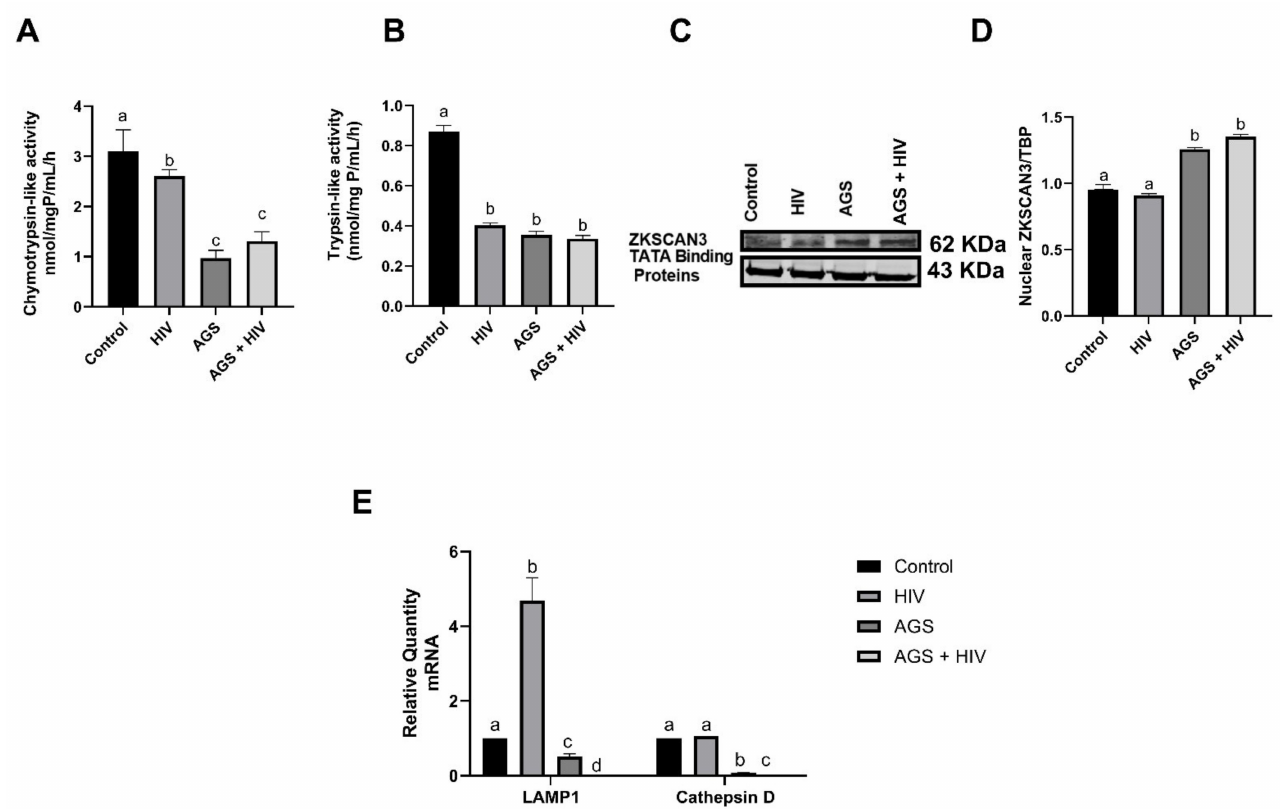
Figure 6. AGS and HIV enhance ZKSCAN3 but suppress TFEB target genes. ( A , B ) Cht-L, and T-L proteasome peptidase activities were detected in cell lysates by in vitro assay using fluorimetric substrates ( C ) Immunoblot analysis of ZKSCAN3 protein expression in RLW nuclear fraction. Equal (20 µ g) amounts of protein were loaded in each lane. β -actin was used as an internal control. ( D ) Quantification of immunoreactive bands of ZKSCAN3 from 3 independent experiments. ( E ) LAMP1 and cathepsin D mRNA expression detected by RT-PCR analysis. GAPDH mRNA was used as an internal control. Data are from 3 independent experiments, presented as the mean ± SEM. Bars marked with the same letter are not significantly different from each other; bars with different letters are significantly different ( p ≤